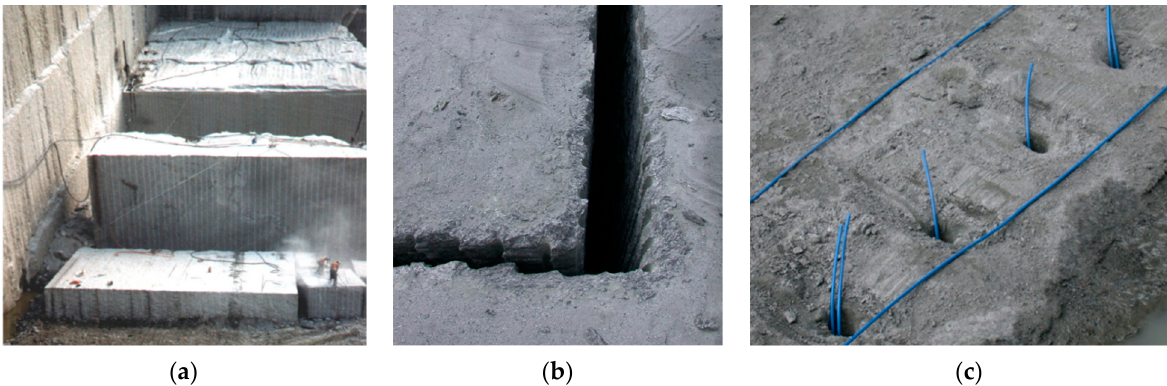
Figure 13. ( a ) Application of splitting to a granite bench (the progressive subdivision into slices and the overturning on the yard to proceed with the squaring operations is noticeable); ( b ) result, consisting of two vertical, perpendicular surfaces (the cut is very regular); ( c ) detail of the holes charged with detonating cord (which assures a decoupling of ~10 between the holes and the charge—very high compared to presplitting).